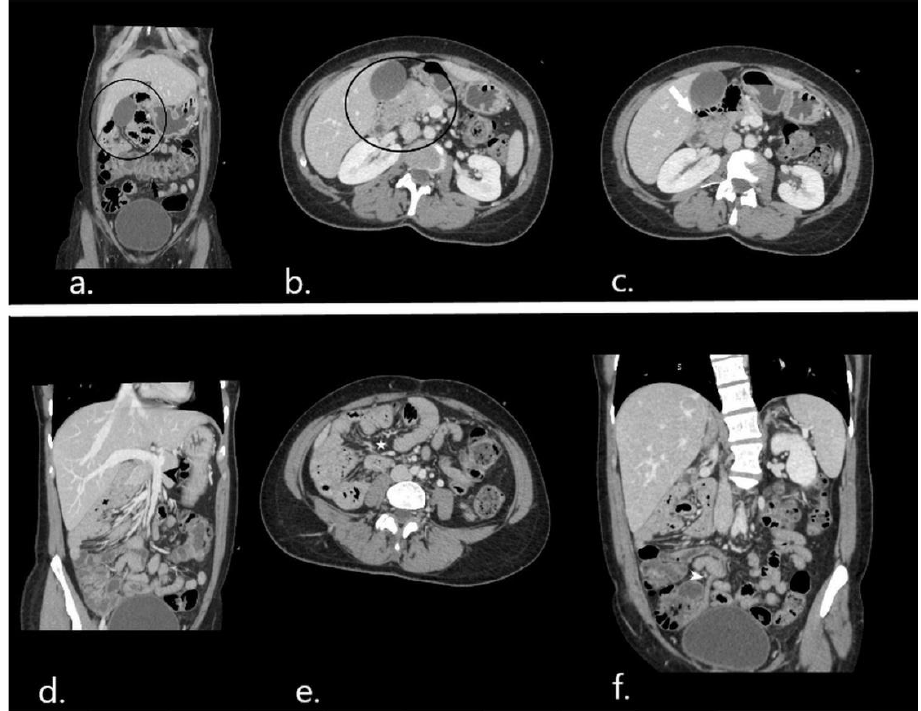
Figure 1. CT scan on admission: coronal ( a ) and axial ( b ) images depict the abnormal position of small bowel loops (in black circle) above the transverse colon (black arrow) and to the right. On axial images ( c ) the horizontal part of the duodenum (white arrow) is positioned on the right and does not run to the left ventrally from the abdominal aorta and inferior vena cava. ( d ) Maximum intensity projection (MIP) image reconstruction on the coronal plane shows an abnormal left course of the superior mesenteric vein (black arrowhead). ( e ) Mesenteric vessel congestion at the site of small bowel herniation. ( f ) Coronal reformatted image showing a normal appendix (white arrowhead).